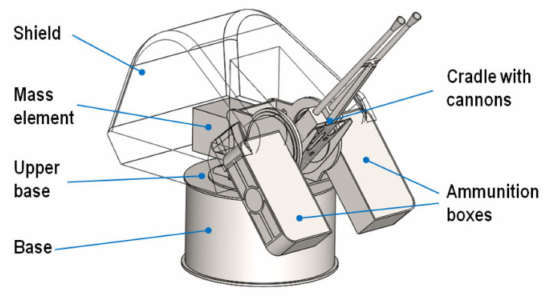
Figure 2. General view of 3D model.